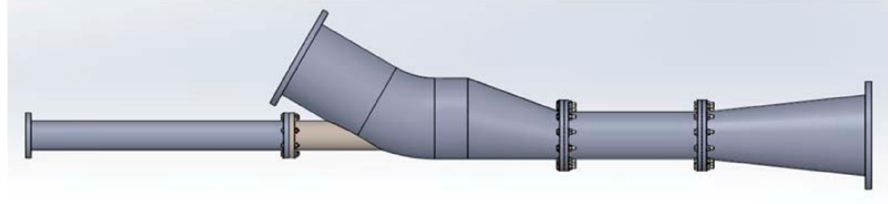
Figure 19. Eccentric